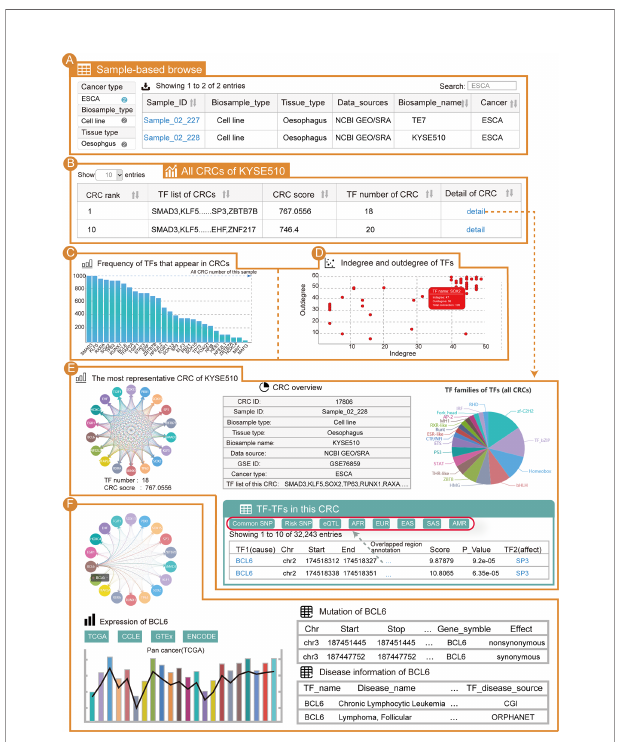
FIGURE 2 | Use of Cancer CRC for esophageal carcinoma (ESCA) analysis. (A) Detailed sample information for ESCA. (B) All CRCs from the KYSE510 cell line (sample ID: Sample_02_228). (C) Frequency of TFs that are in the CRCs of Sample_02_228. (D) Scatter graph of TF degree of the CRCs in Sample_02_228. (E) Details of the most representative CRC in Sample_02_228. (F) Details of the TF BCL6 in these